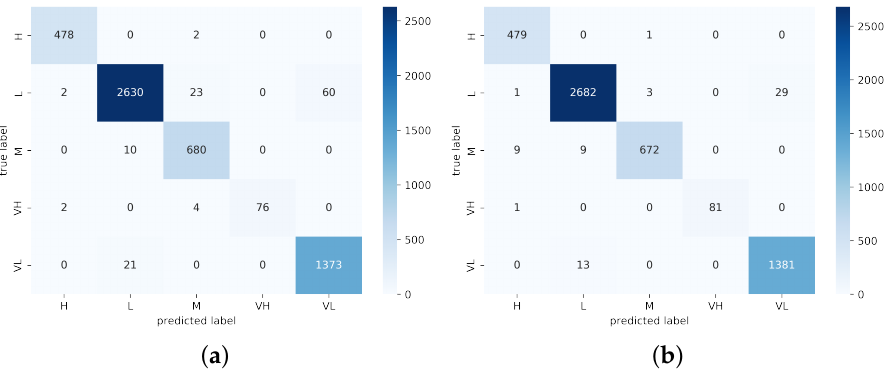
Figure 9. Confusion matrix heat map of UCSD Ped1 for ( a ) MCMS-BCNN-Attention+densenet121 and ( b )